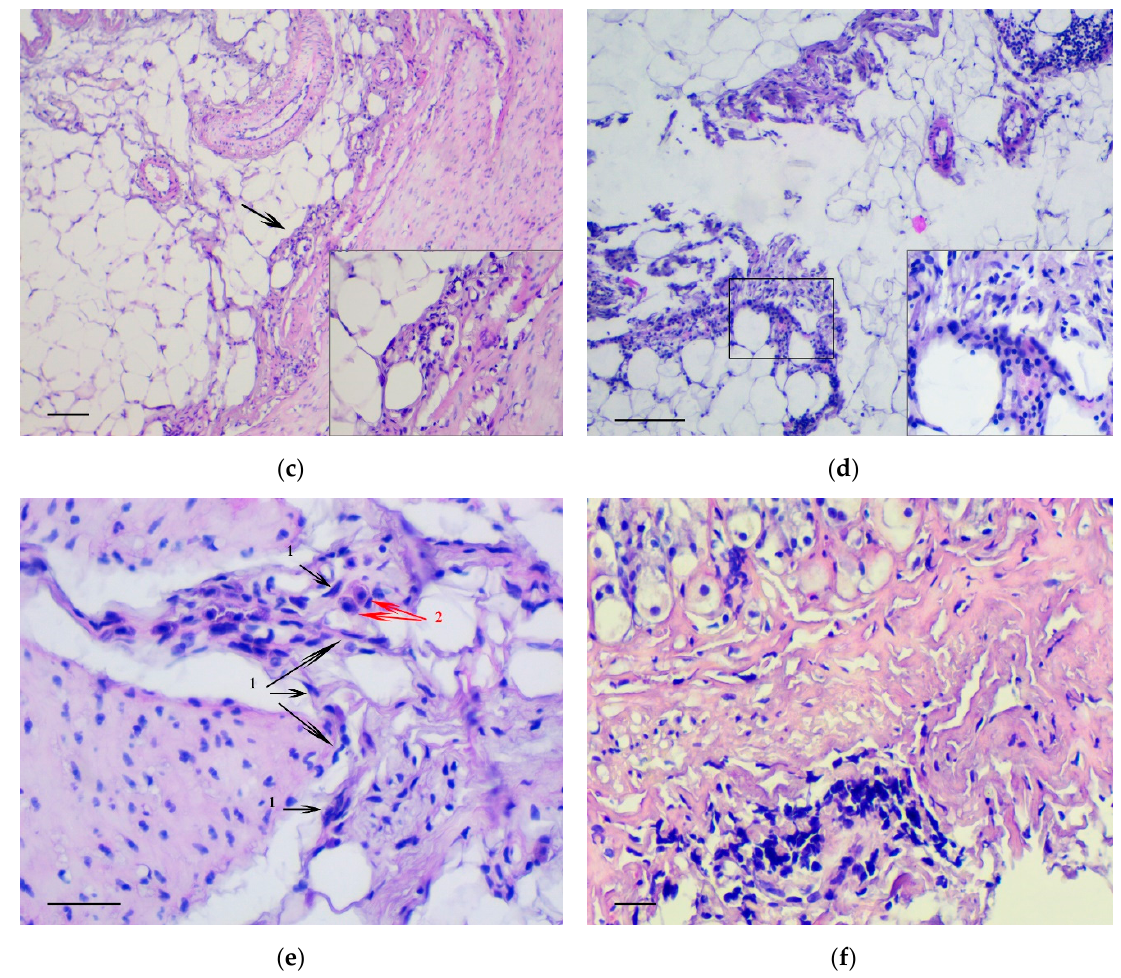
Figure 4. Invasion of tumor cells. H&E staining. ( a ) Tumor embolus in the vessel, scale bar 100 µm. ( b ) Invasion of tumor cells in muscle layer (arrows), scale bar 100 µm. ( c ) Invasion of tumor cells in serosa layer (arrow). In the box the marked area is shown at magnification, scale bar 200 µm. ( d ) Invasion of tumor cells in omentum. In the box the selected area is shown at higher magnification, scale bar 200 µm. ( e ) The clusters of tumor cells in the muscle layer consisting of fibroblast-like cells with a curved shape (1-black arrows) and cells with finely dispersed oxyphilic inclusions in the cytoplasm (2-red arrows), scale bar 100 µm. ( f ) The cells with large, polymorphic, hyperchromic nuclei and with a markedly increased nuclear/cytoplasmic ratio in the muscle layer of stomach, scale bar 100 µm.